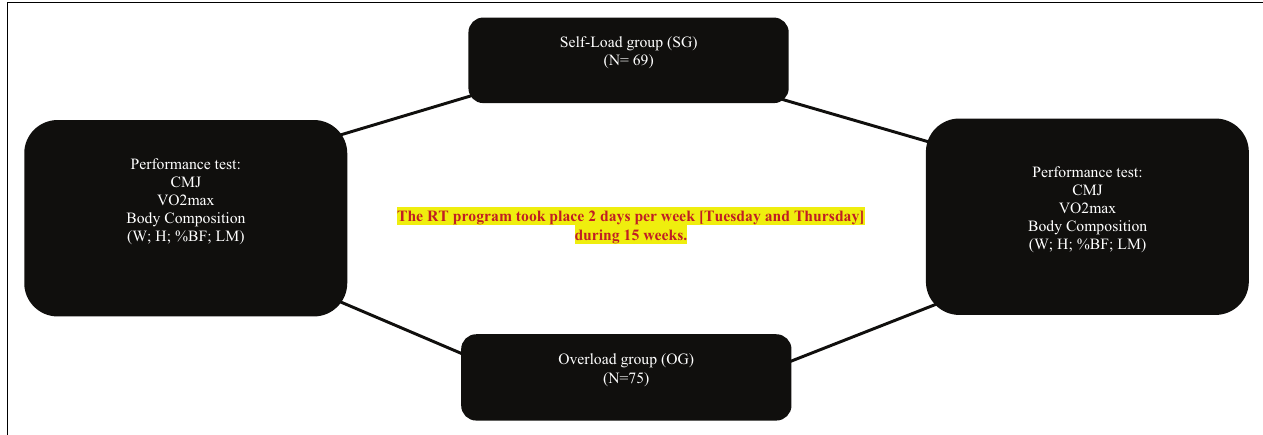
FIGURE 1 | Schematic presentation of the study design. CMJ, countermovement jump; VO 2 max, maximal oxygen consumption; U, under; RT, resistance training; SG, self-load group; OG, overload group; W, weight; H, height; % BF, % body fat; LM, lean